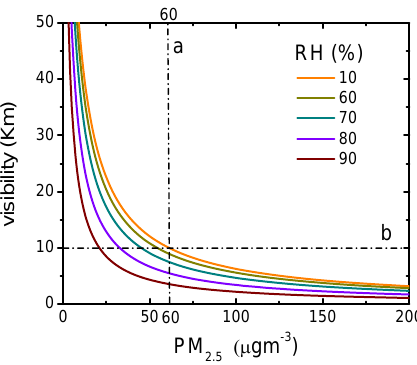
Fig. 12. The equivalent curve for visibility depending on the mass concentration of PM 2.5 and relative humidity. Line (b) is the standard for visibility equal to 10 km, and line (a) is the limit for mass concentration of PM 2.5 under dry condition (RH=10%).